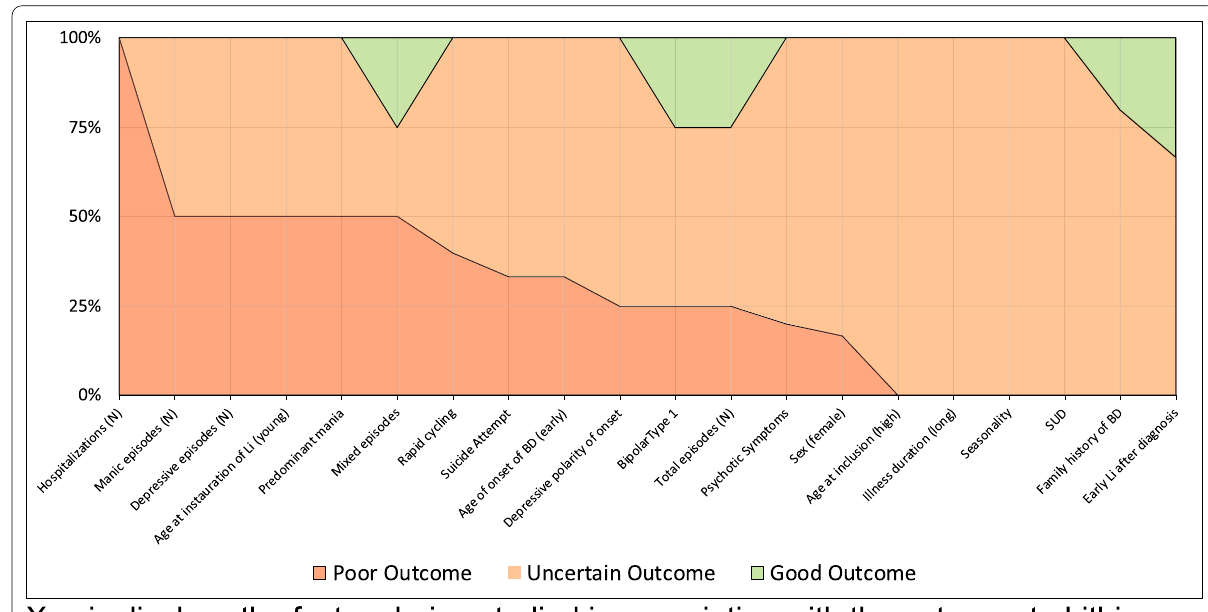
Fig. 3 Diagram graph of all potential predictors being studied in at least 2 studies, only in good or borderline good quality